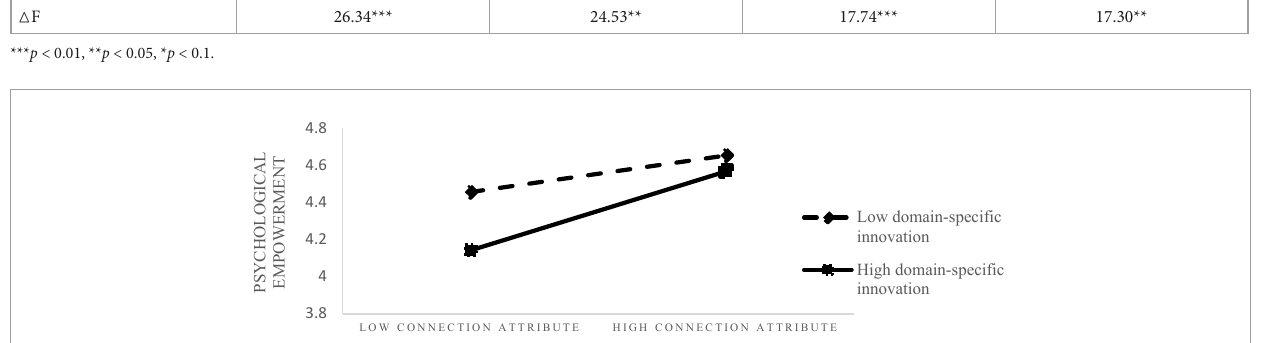
FIGURE2 The moderating role of Consumer domain-specific innovation between connection attribute and psychological